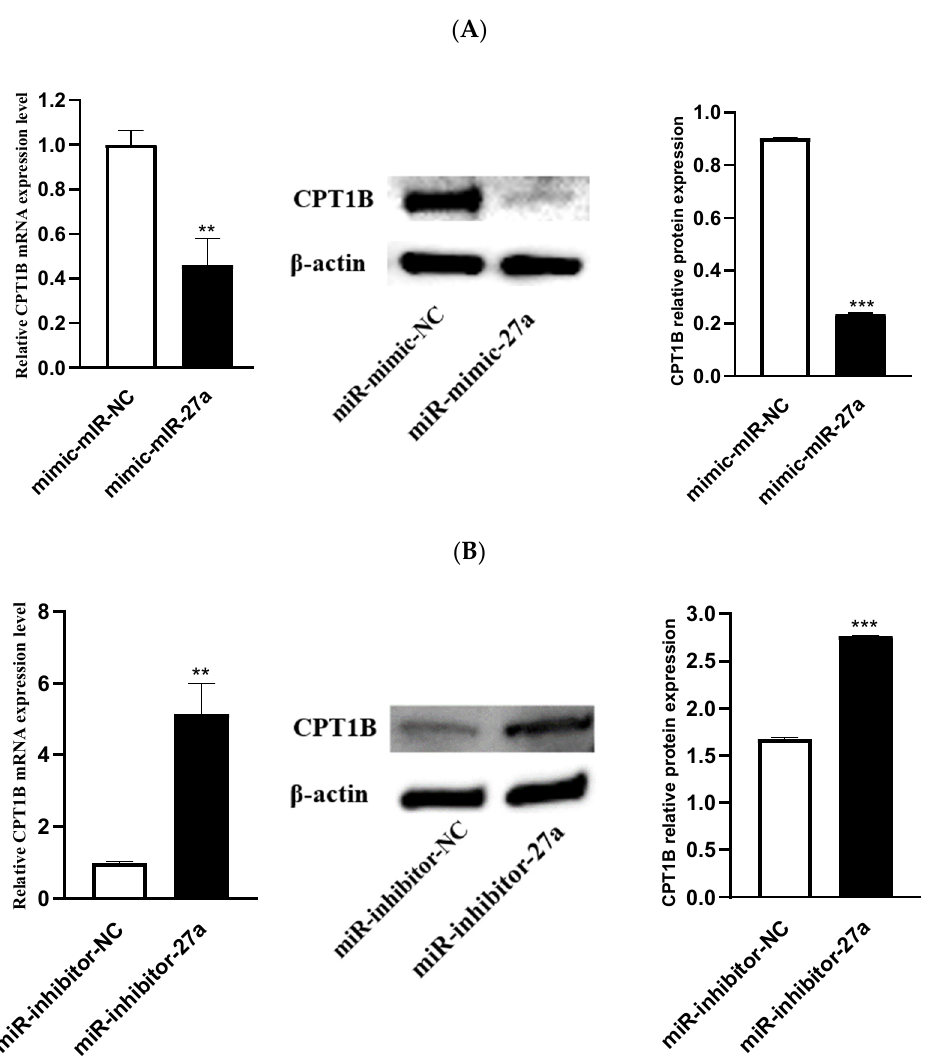
Figure 5. Impact of miR-27a on the CPT1B mRNA levels and protein expression. ( A ) Effects of transfection of miR-mimic-NC and miR-mimic-27a on CPT1B gene expression and protein in adipocytes. ( B ) Effects of transfection of miR-inhibitor-NC and miR-inhibitor-27a on CPT1B gene expression and protein in adipocytes. ** p < 0.01, *** p < 0.001.